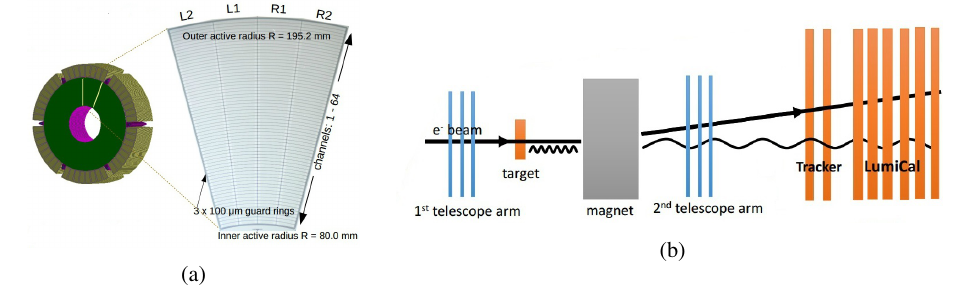
Figure 1: a) LumiCal design for ILD and one of its silicon-sensor tiles. b) A schematic layout (figure is not to scale) of the test beam 2016 for LumiCal.